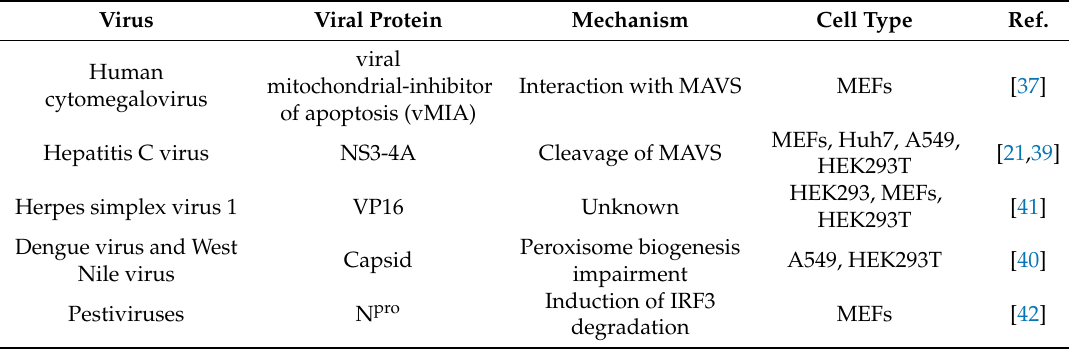
Table 1. Viral evasion strategies that target peroxisome-dependent antiviral signaling.